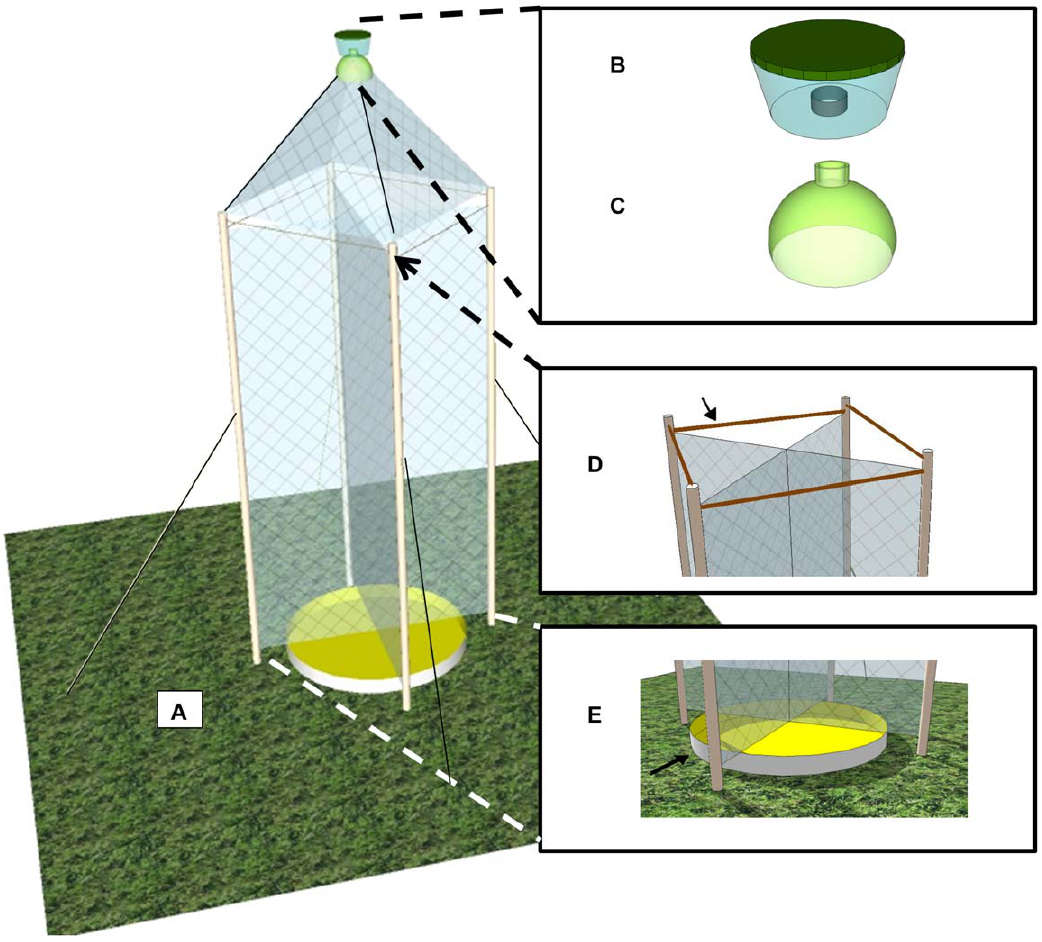
Figure 1. The Composite Insect Trap. A ) The Composite Insect Trap is a passive trap designed to collect as broad a spectrum of insects as possible, utilizing ideas from other, more specialized trap designs in a novel construction. The plastic components of the cone form the collection chamber (B and C). B ) The modified plastic container with embedded bottle top will hold the alcohol for killing and storing insects. C ) The top of the two-liter bottle will be attached to the mesh fabric of the cone. D ) The bamboo rods stabilize the top part of the flight intercept trap. E ) The yellow pan trap sits below the flight intercept trap and is filled with soapy water to act simultaneously as a killing and collecting dish.